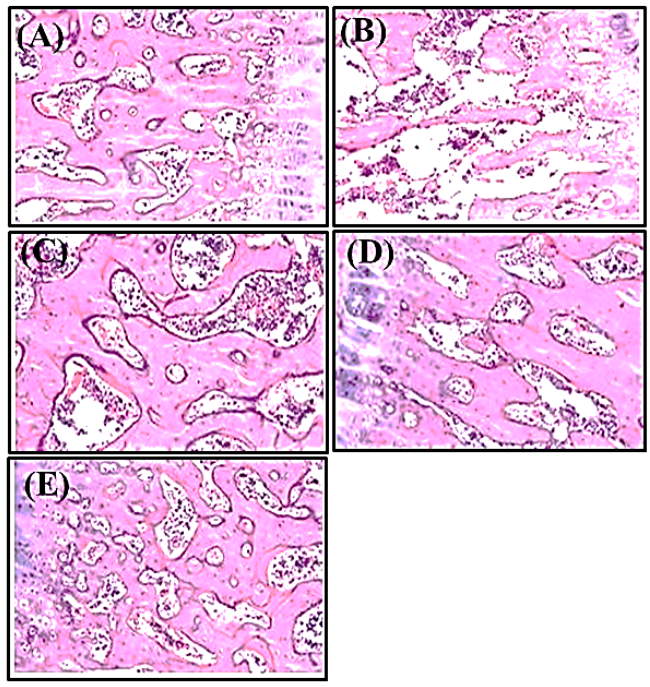
Figure 3. Histopathology of femur bone which was observed under (40 × ) magnification ( A ) Normal control, ( B ) diseased control only, treated with methyl prednisolone (28 mg/kg, s.c once a week for four weeks), ( C ) standard control, treated with alendronate (2 mg/kg, p.o for 8 weeks) and methyl prednisolone (28 mg/kg, s.c once a week for four weeks), ( D ) MFT (200 mg/kg p.o for 8 weeks) along with prednisolone (28 mg/kg, s.c once a week for four weeks), ( E ) MFT (400 mg/kg p.o for 8 weeks) along with prednisolone (28 mg/kg, s.c once a week for four weeks).